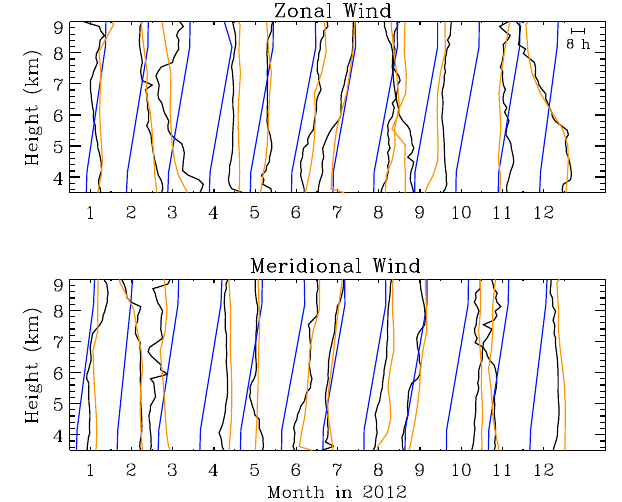
Figure 5. Similar to Fig. 4, but for the DT phase in the height range of